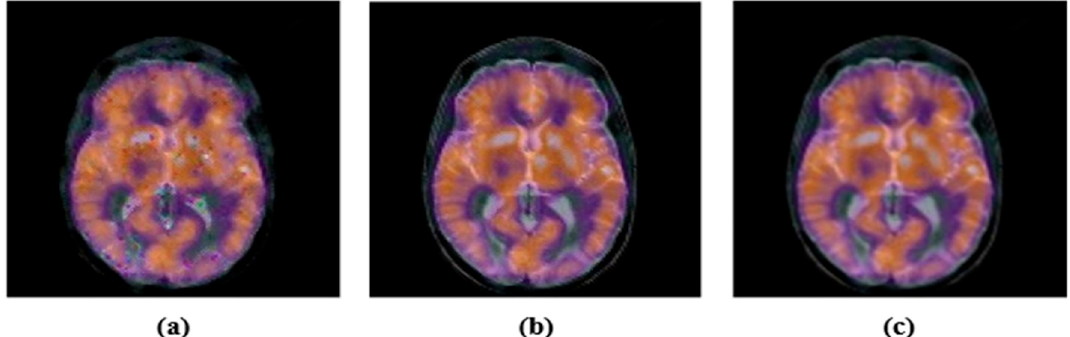
Figure 7. Images after filtering attack: ( a ) median-filtering 3 × 3; PSNR = 24.2301; ( b ) Gaussian-filtering 3 × 3; PSNR = 18.7036; ( c ) average-filtering 3 × 3 PSNR = 19.2364. Table 1. Common image processing attacks and their